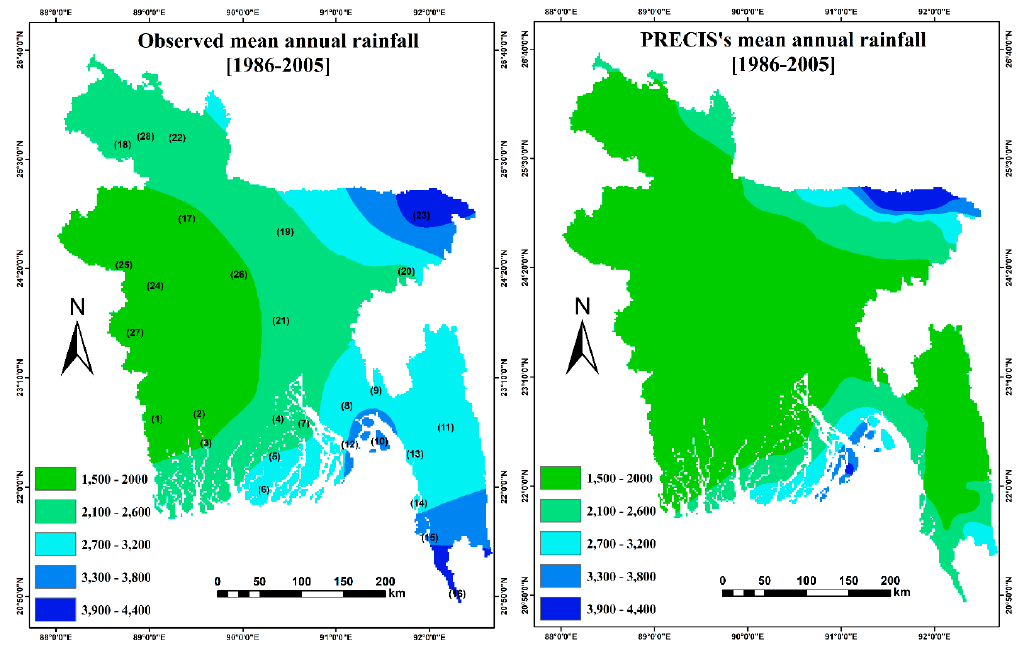
Figure 1. Comparison of spatial distribution of observed ( left ) and simulated ( right ) mean annual rainfalls over the base period (1986–2005). Here, numerical numbers in between black brackets in ( left ) denotes the location IDs of the observed rainfall stations as provided in Supplementary Table S1.